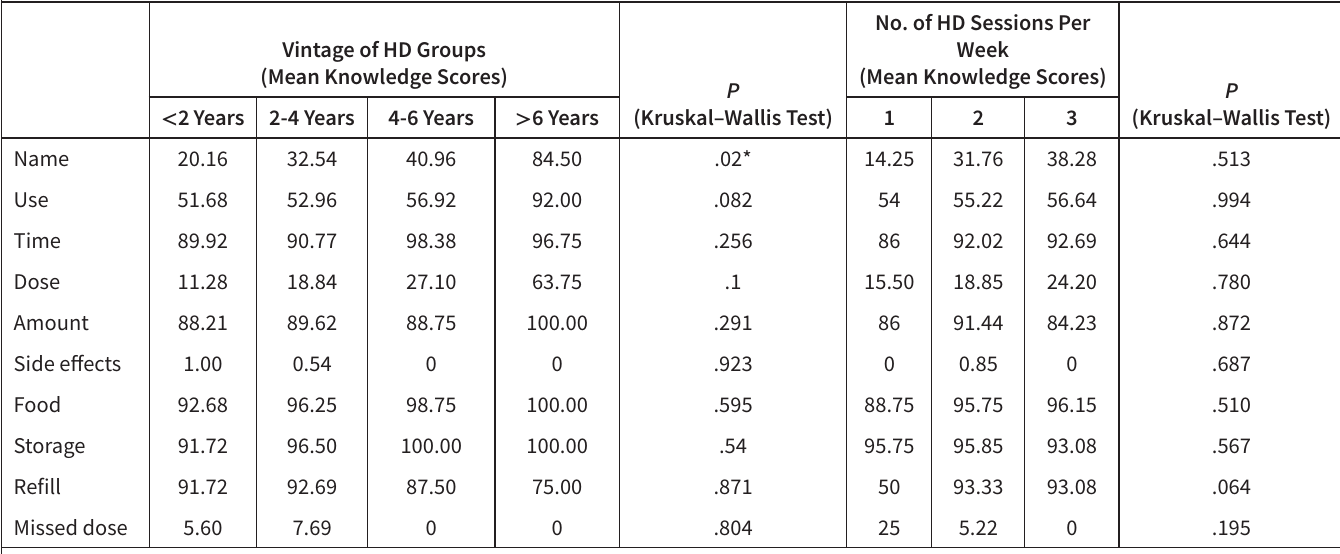
Table 6. Comparison of Medication Knowledge Scores Between the Vintage of HD and No. of HD Sessions Per Week Vintage of HD